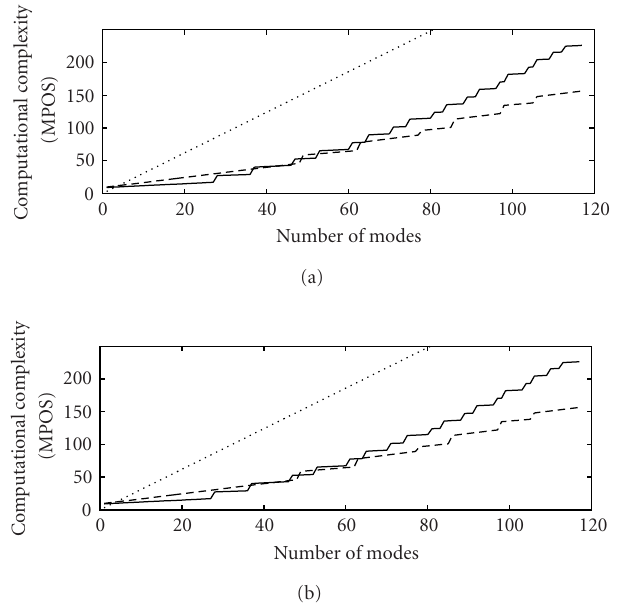
Figure 6: Computational complexities of the FTM simulations dependent on the number of simulated modes at audio rate (dotted line), and with multirate approaches with P = 7 (dashed line) and P = 15 (solid line). (a): Linearly vibrating string, (b): vibrating string with nonlinear slap forces.